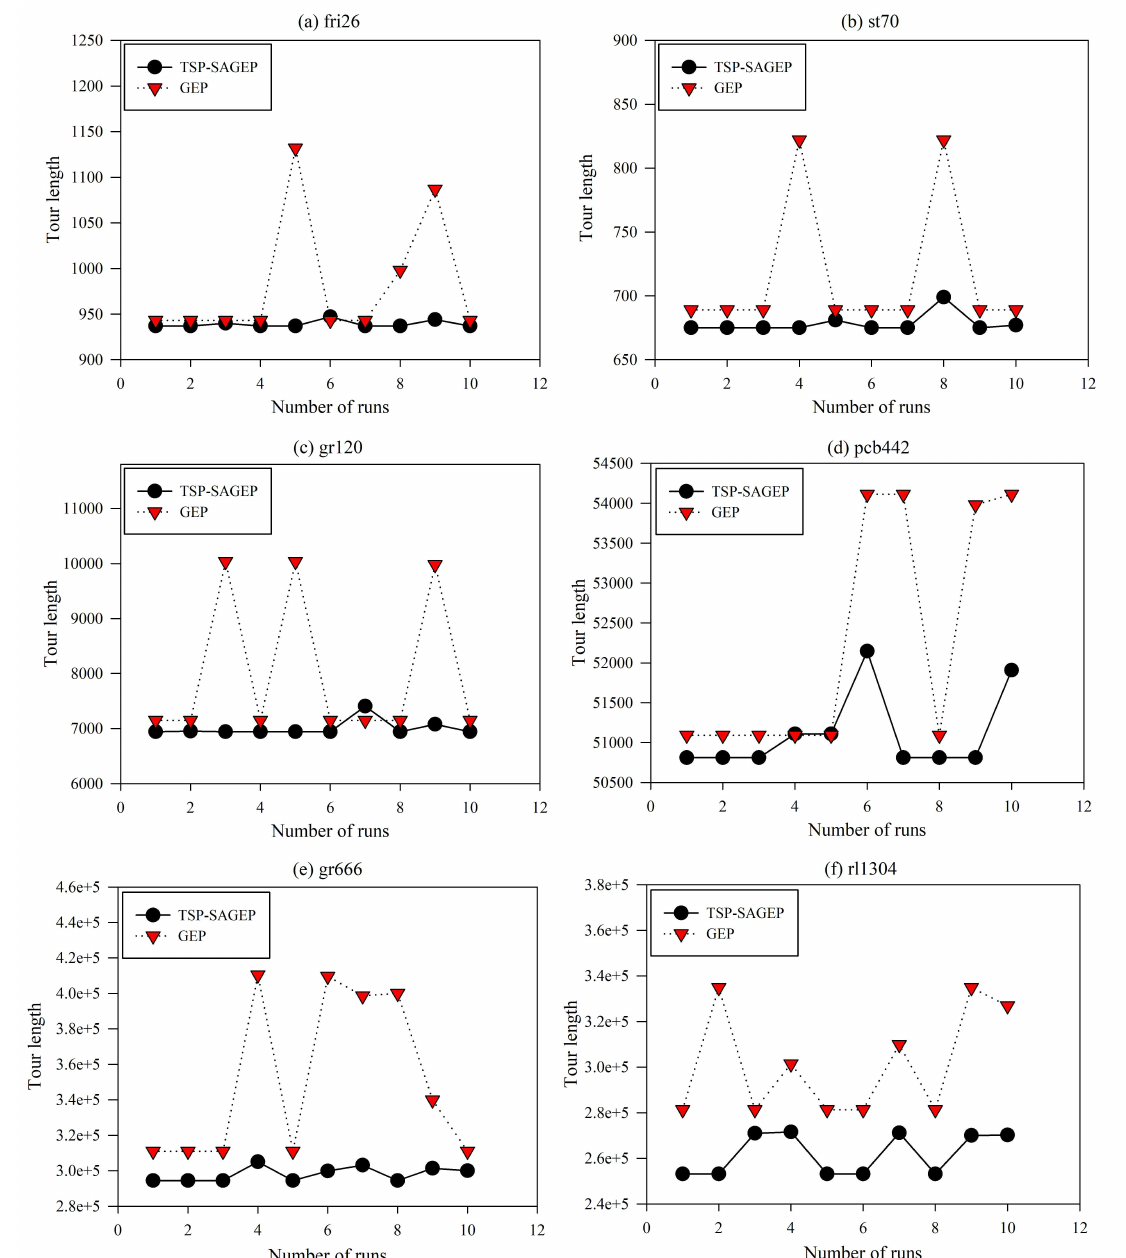
Figure 4. Comparison of tour length based on TSP-SAGEP and GEP for six datasets with an increase in the number of